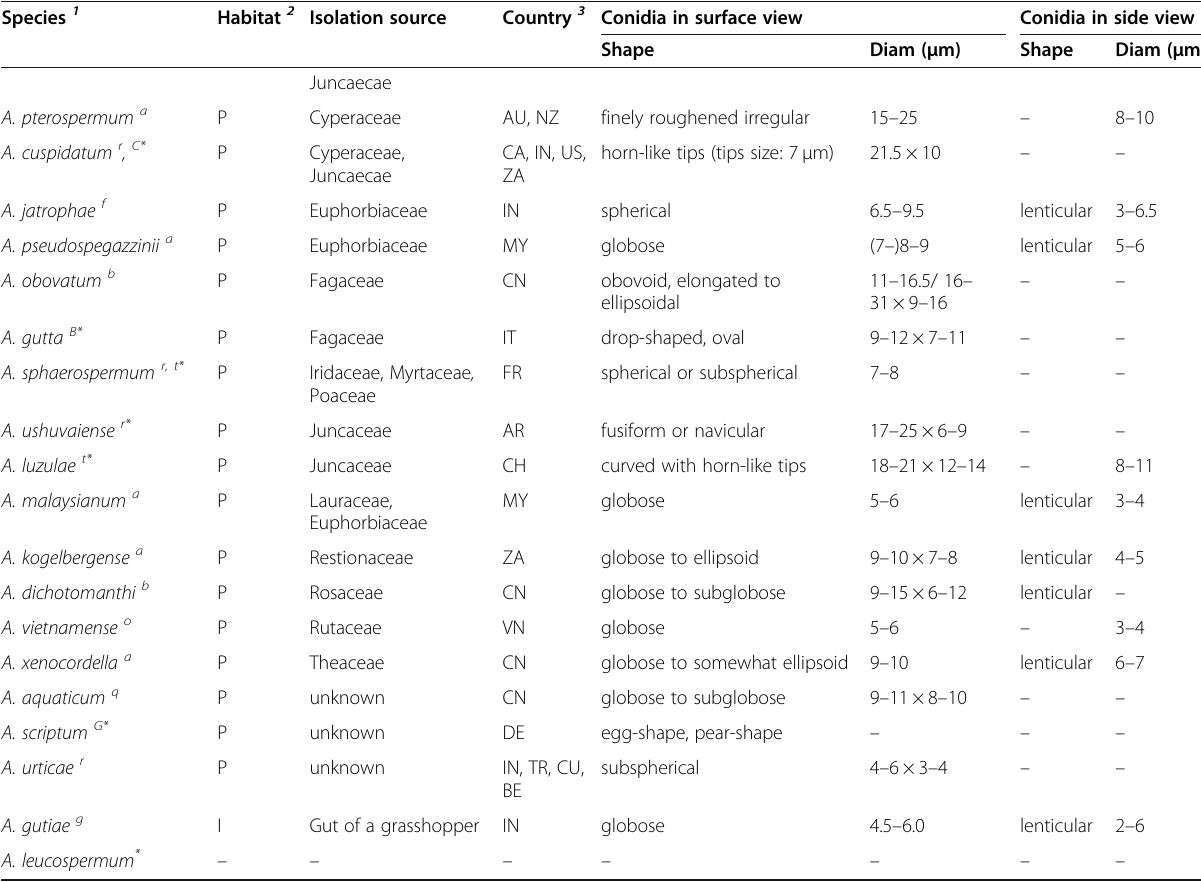
Table 2 Summary of conidial morphology of Arthrinium species. Newly established species in this study are shown in bold